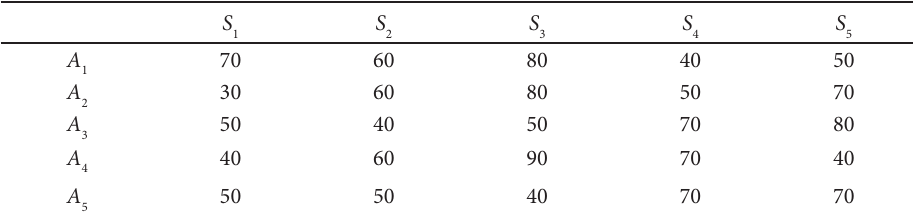
Table 4. Payoff matrix – Collective